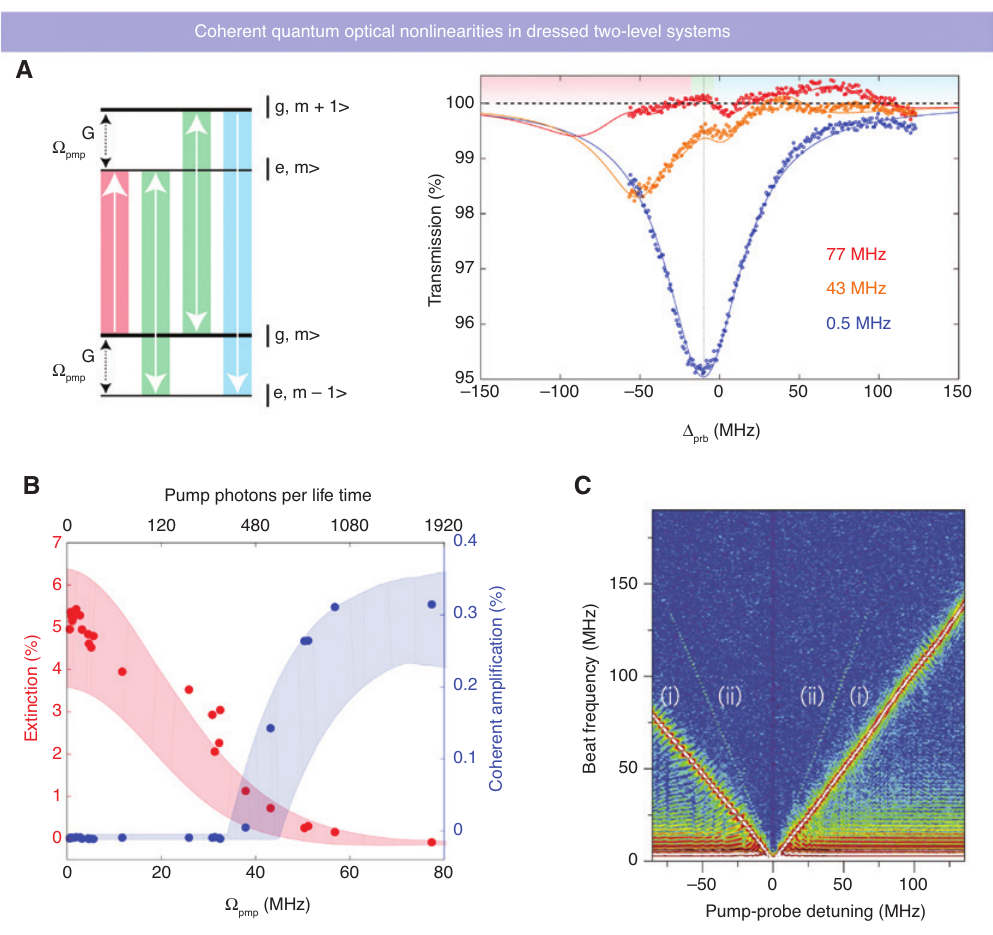
Figure 5: Coherent quantum optical nonlinearities in dressed two-level systems. (A) The transmission spectra of photons scattering from a single organic molecule embedded in a nanoguide evolves nonlinearly as a function of the strength of a control beam with Rabi frequency Ω [23]. The features of the red and orange curves can be understood in pmp terms of the three available transitions between the states of the system, as shown to the left; each manifold of states is described by the state of the TLS and the photon number, here | e 〉 or | g 〉 and | m 〉, respectively, and the level splitting is given by the generalized Rabi frequency G Here, a Stark shift of the resonance (red), a coherent energy transfer between the signal and control photons (green), and a coherent amplification of the signal photons (blue) are observed. (B) The nonlinear dependence of the coherent extinction and amplification as a function of control beam strength. Adapted from [23]. (C) Four-wave mixing observed using a single organic molecule as the nonlinear medium. This nonlinear signal manifests at twice the beat frequency (ii) of the scattered signal (i). Adapted from